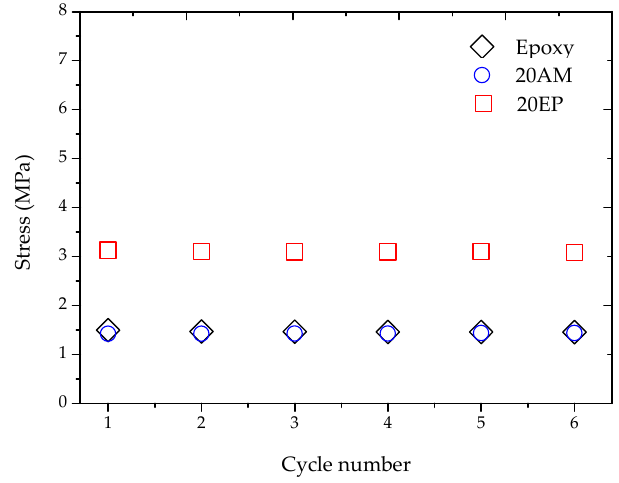
Figure 9. The influence of SME cycles on bending stress of representative EPOSS samples.